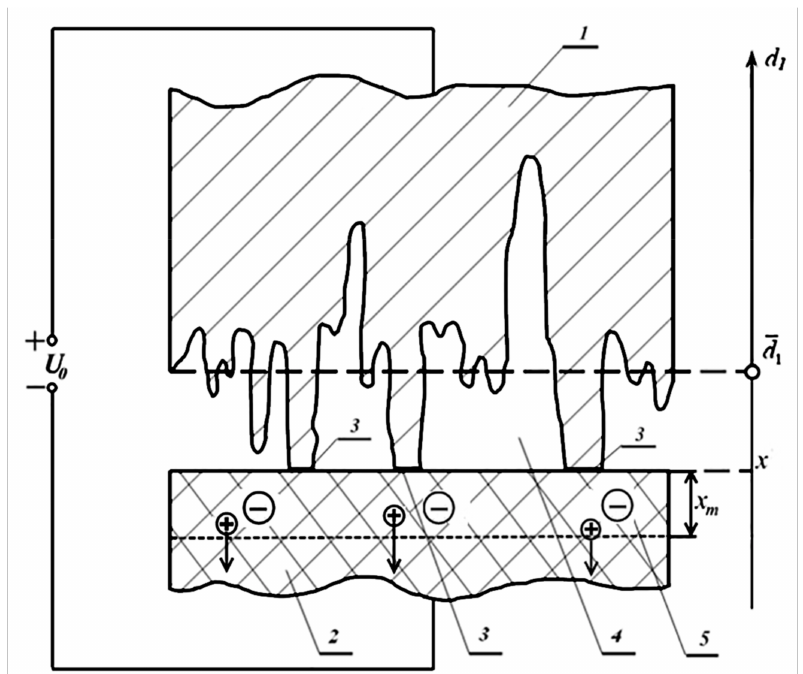
Figure 8. A model for calculating the ponderomotive pressure when manufacturing an electroadhesive joint ionic dielectric-to-conductor [25]. 1—Metal (semiconductor); 2—dielectric; 3—area of actual contact; 4—air gap due to the roughness of the contacting surfaces; 5—layer of localization of space charge in the